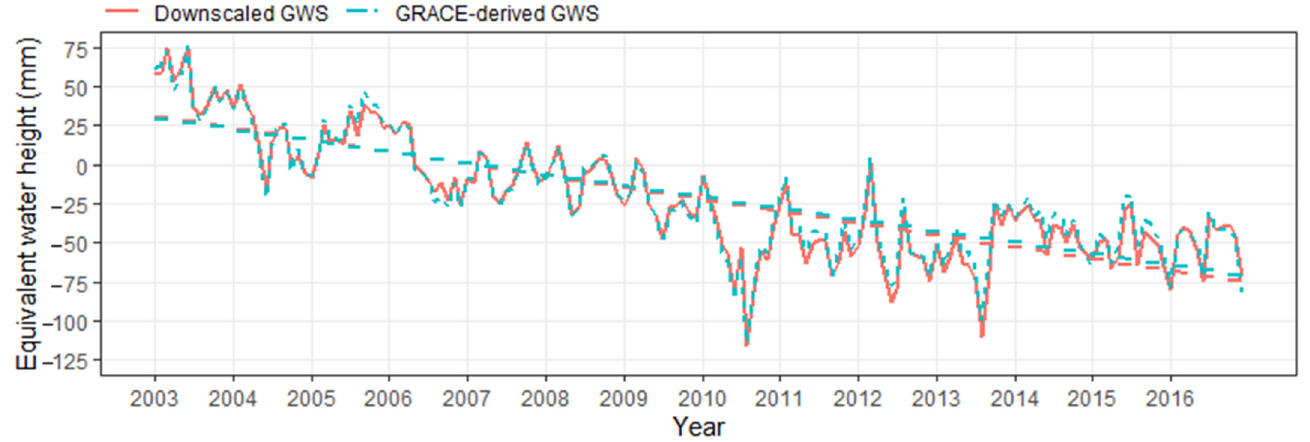
Figure 11. GWS time series before and after downscaling in IBIS.